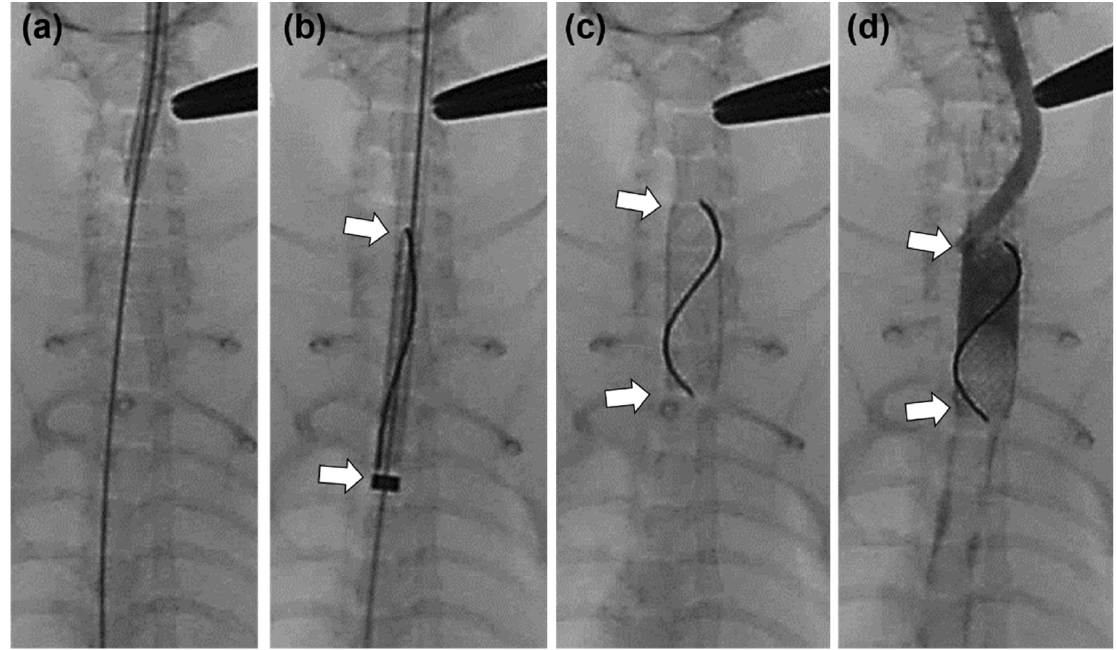
Figure 1. Radiographic images obtained during I-SEMS placement showing the technical steps of stent placement. ( a ) Radiographic image showing a guidewire with a catheter. ( b ) A stent delivery system (arrows) inserted into the rat esophagus. ( c ) Radiographic image showing the placed stent (arrows) in the esophagus. ( d ) Esophagographic image showing the patency of the I-SEMS immediately after placement. I-SEMS, interwoven self-expandable metallic stent.